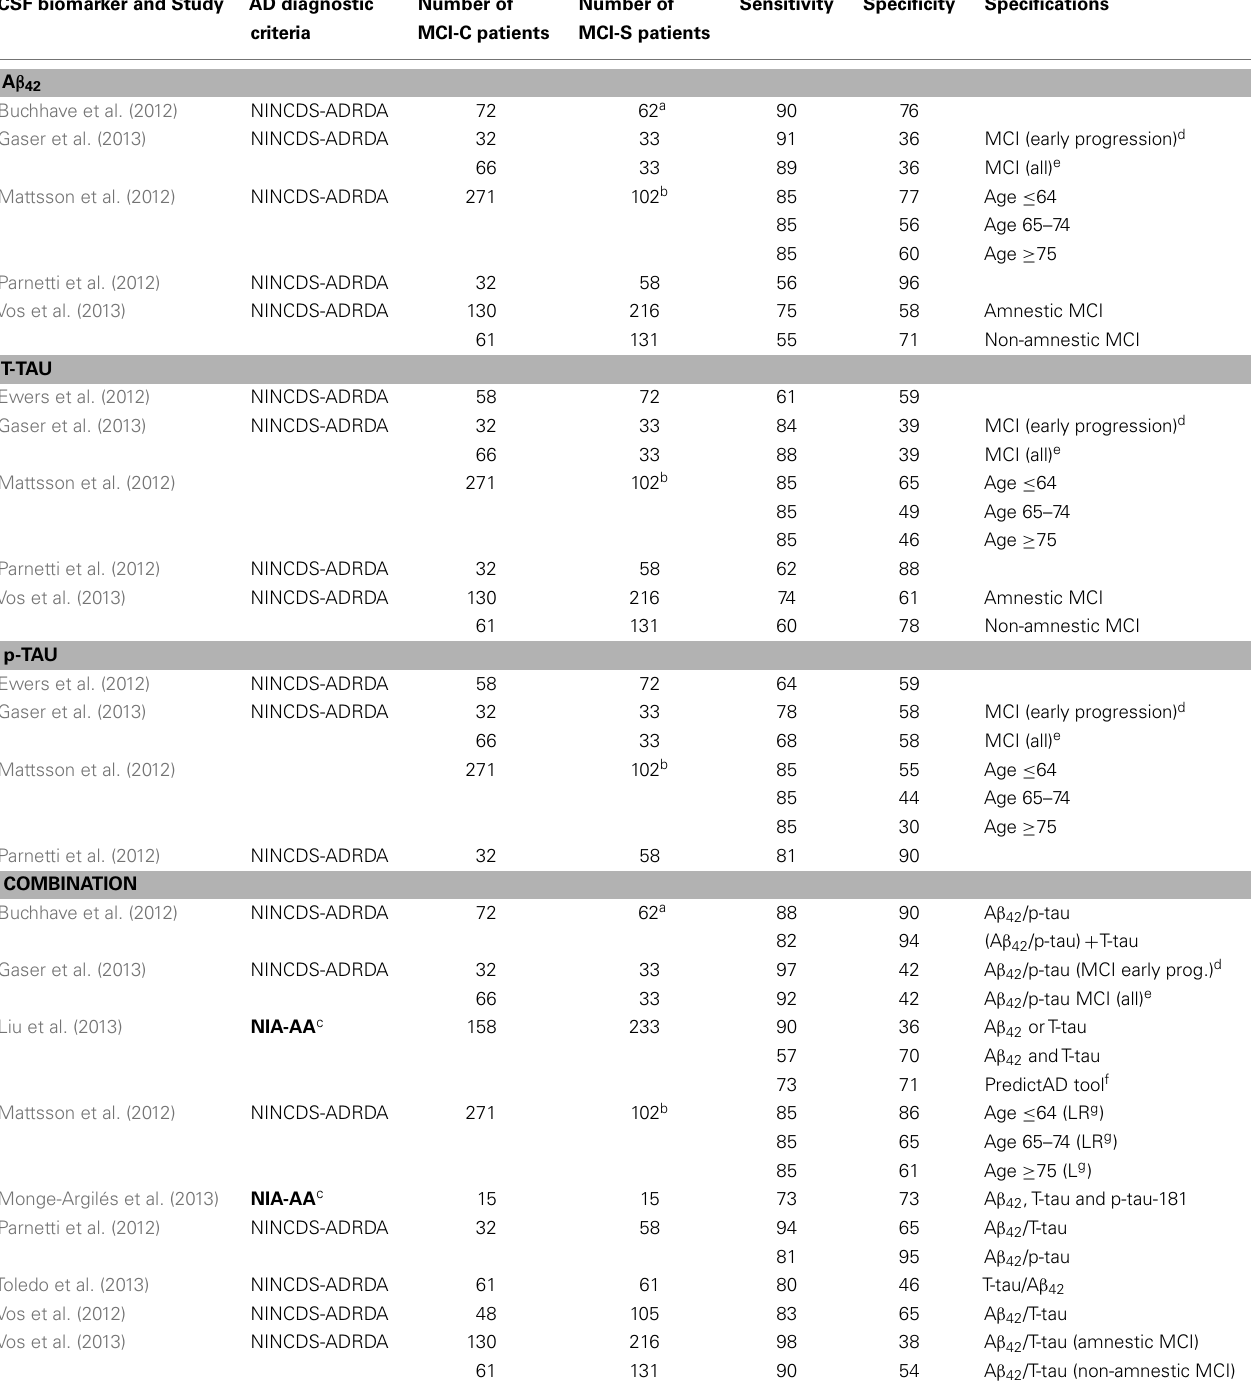
Table 8 | Primary studies published after the new revised diagnostic criteria (MCI-C vs. MCI-S): sensitivity and specificity